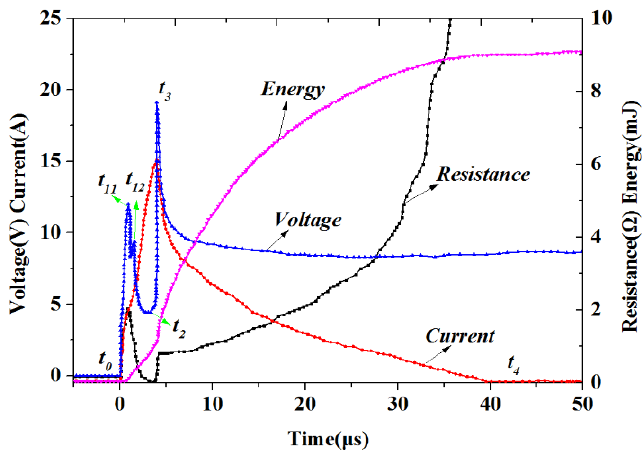
1 – t 2 stage, liquid silicon evaporates and is transformed into gaseous silicon. t 4 was